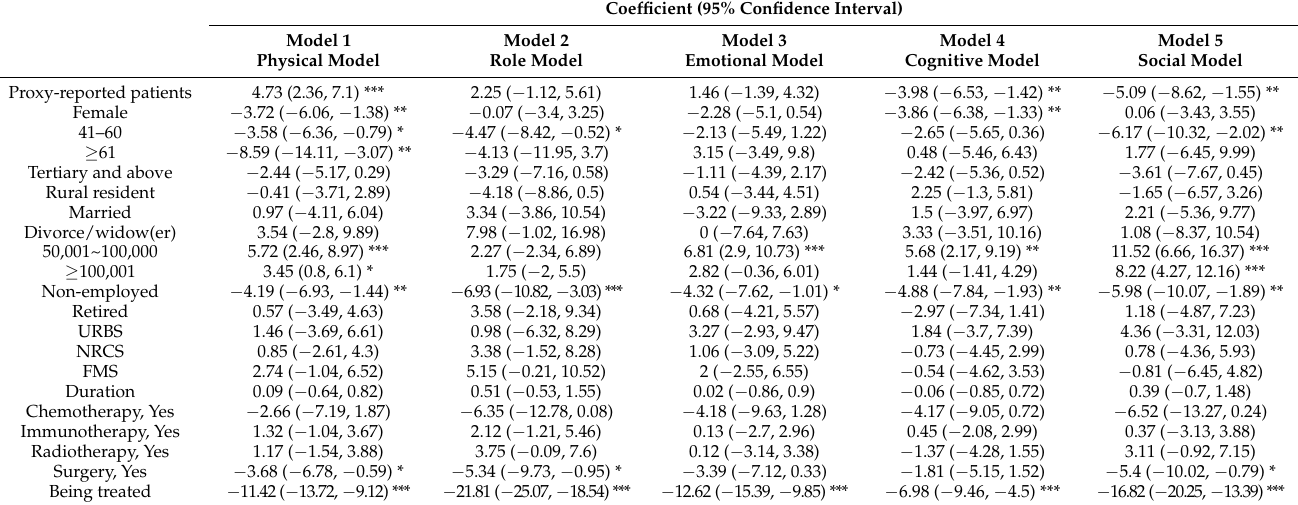
Table 3. Relationship between HRQoL and responded type adjusted by socioeconomic characteristics and health